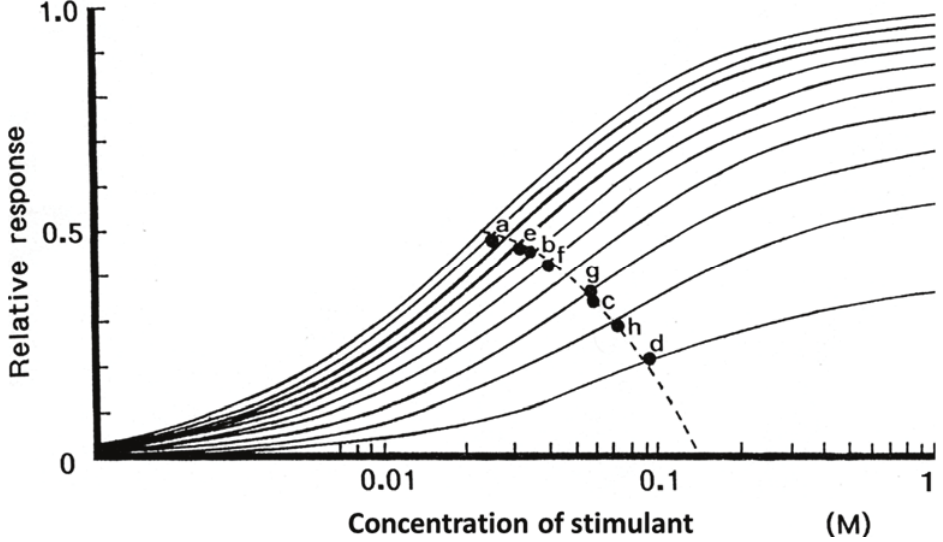
Figure 1. Theoretical concentration-response curves in an adapted single chemoreceptor cell, calculated according to Beidler [91] equation of R/R m = 1/(1 + C 1/2 /[S]), where R/R m is relative response to the maximum response; C 1/2 is mid-point concentration; [S] is the concentration of the stimulant. The concentration-response curves are drawn at various adapted states. As the ratio of a receptor activation/inactivation-dependent receptive membrane conductance to leak conductance, (rg/G, where r, number of functional receptor molecule; g, conductance change per activated receptor molecule; G, leak conductance at the receptive membrane) is changed to be 100, 90, 80, 70, 60, 50, 40, 30, 20, and 10% of that at the non-adapted state by sensory adaptation, C 1/2 increases and responsiveness of the cell is reduced but the sensory resolution increases, especially for high concentration range. A dotted line follows mid-points of the theoretical concentration-response